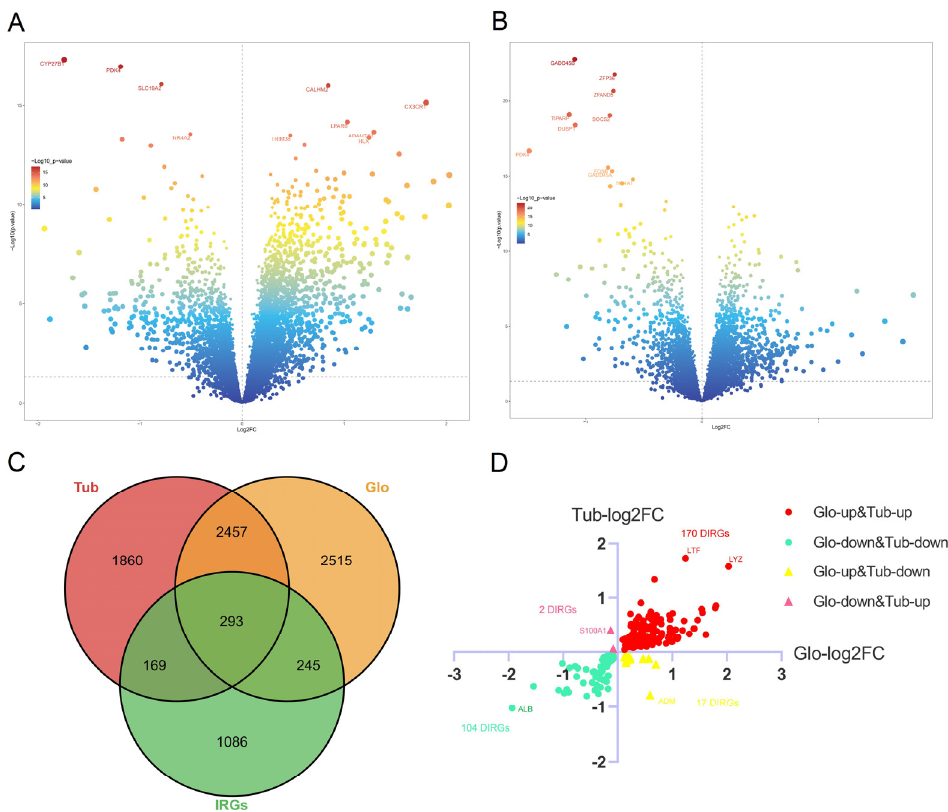
Figure 2. Identification of common DIRGs in data 1 and data 2. ( A ) Volcano map of all DEGs of data